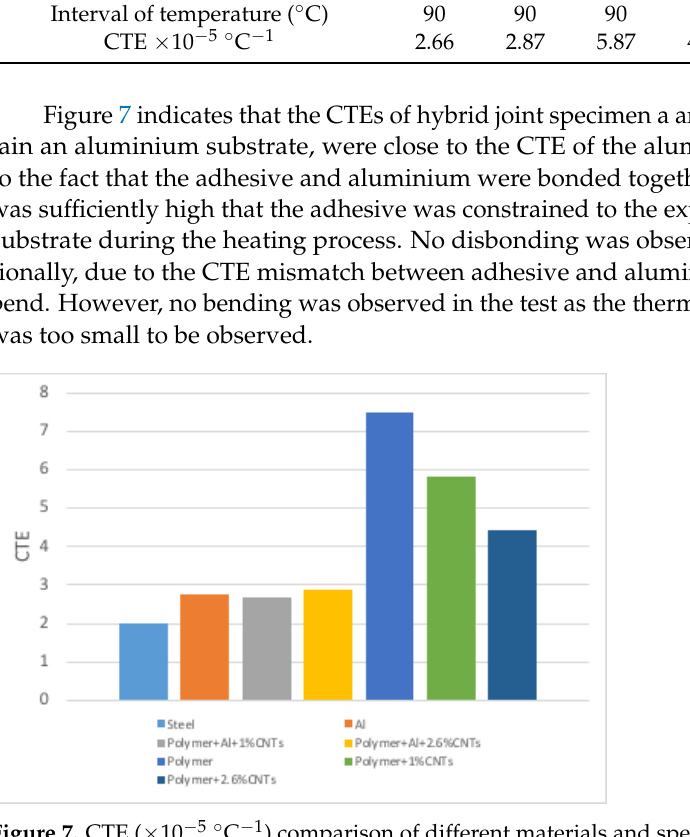
Figure 7. CTE ( × 10 − 5 ◦ C − 1 ) comparison of different materials and